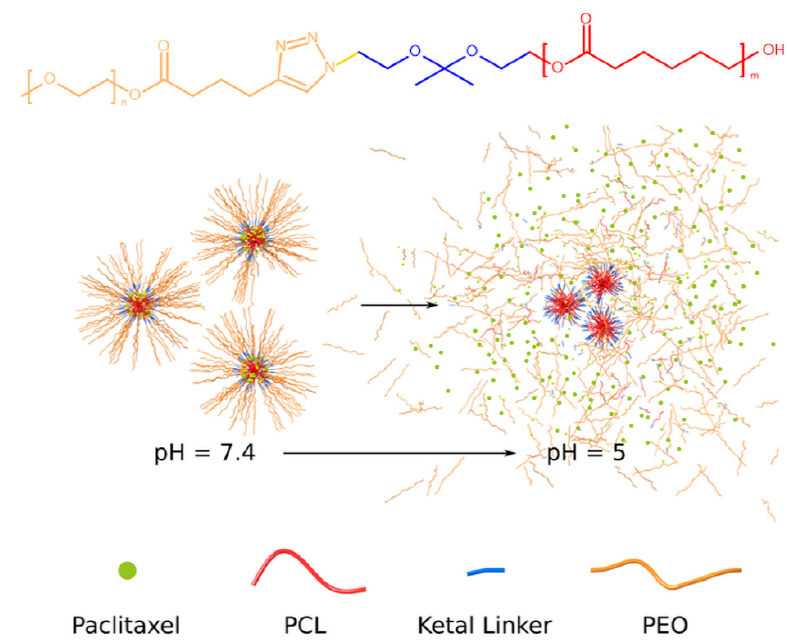
Figure 1. Chemical structure of the pH-triggered acid-labile block copolymer MPEO 44 - b -PCL 17 ( top ) and the schematic nanoparticles assembly/disassembly mechanism at pH ~5.0 ( bottom ).